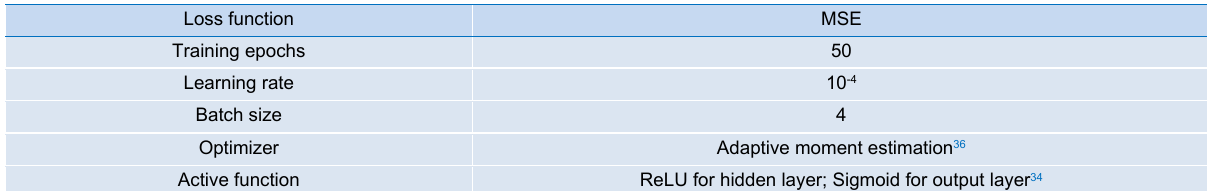
Table 5 | Neural network training